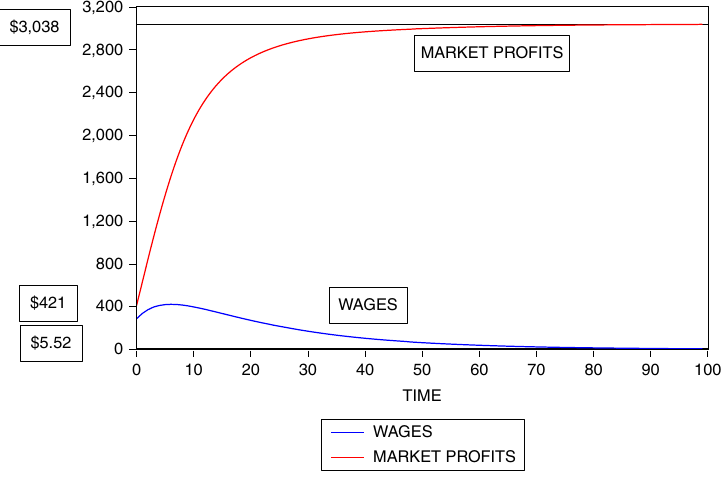
Figure 4. The income distribution of labor and profits in the long run: labor-reducing